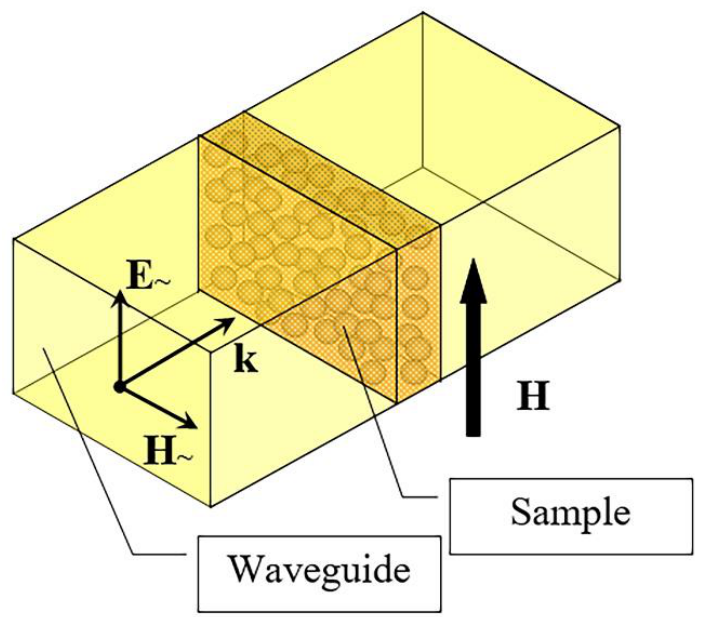
Figure 6. Scheme of microwave measurements.